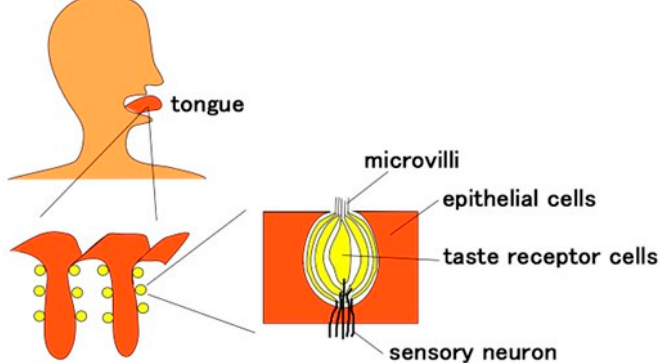
Figure 1. Schematic anatomical diagram of gustatory receptor in a human tongue.